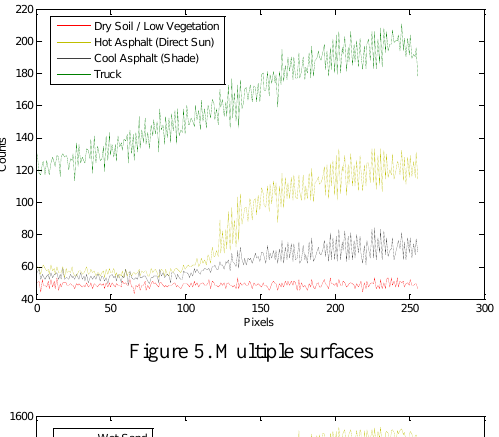
Figure 5. Multiple surfaces